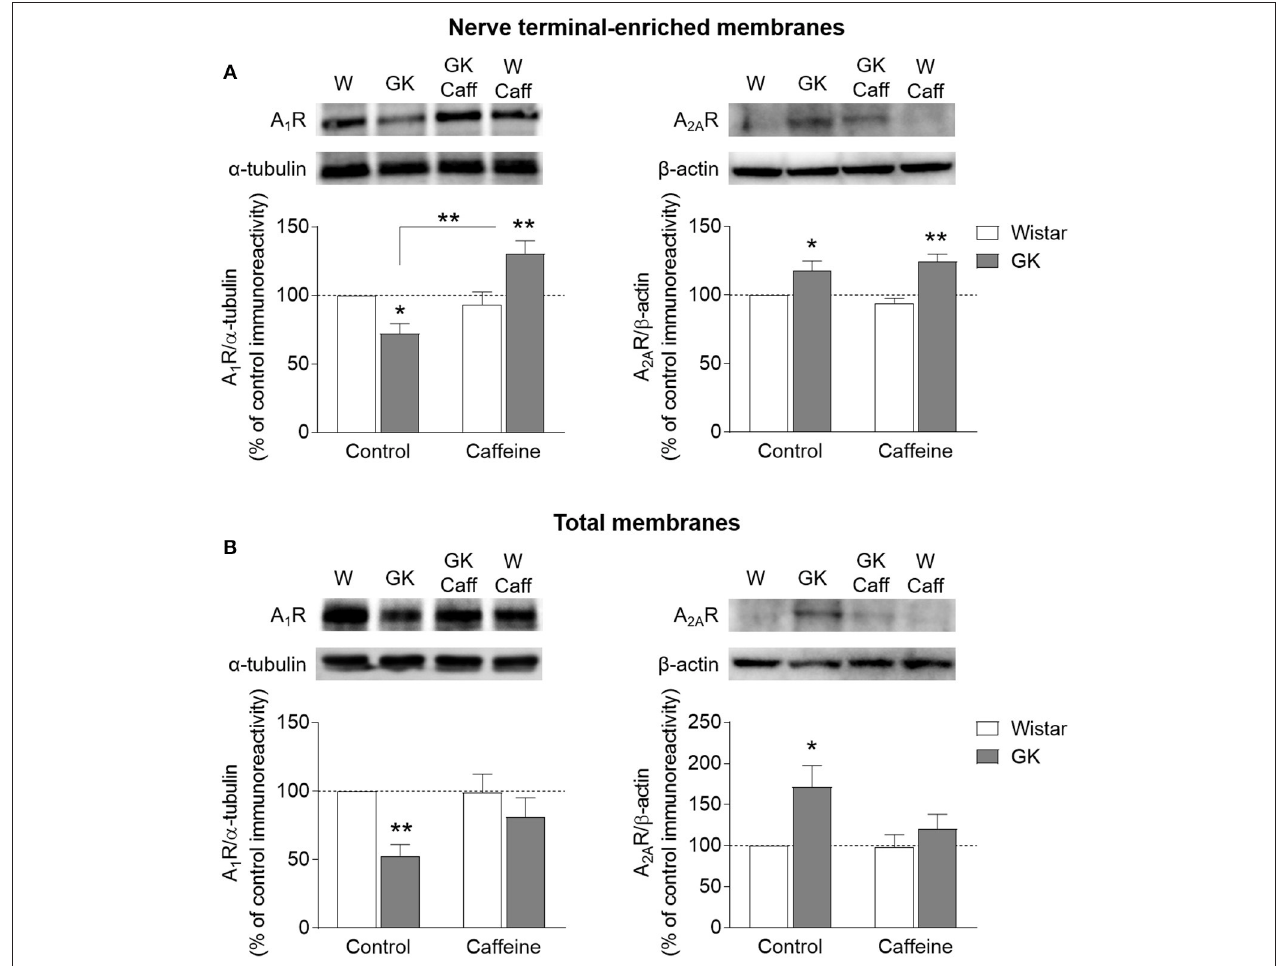
FIGURE 6 | Density A 1 R and A 2A R analyzed by Western blot in nerve terminal-enriched membranes (A) and total membranes (B) from the hippocampus of GK and Wistar (W) rats, either receiving 1 g/L caffeine (Caff) or tap water. Samples were loaded in SDS-PAGE gels at a protein concentration of 40 or 150 µ g for A 1 R ( n = 6–8) and A 2A R ( n = 2–3), respectively. Immunoreactivity was normalized to either α -tubulin or β -actin, and calculated as percentage of control in the same Western blot experiment. Symbols represent LSD test results after ANOVA with either significant diabetes effect or significant diabetes-caffeine interaction: * P < 0.05, ** P < 0.01 for GK vs. Wistar in the respective treatment group or as